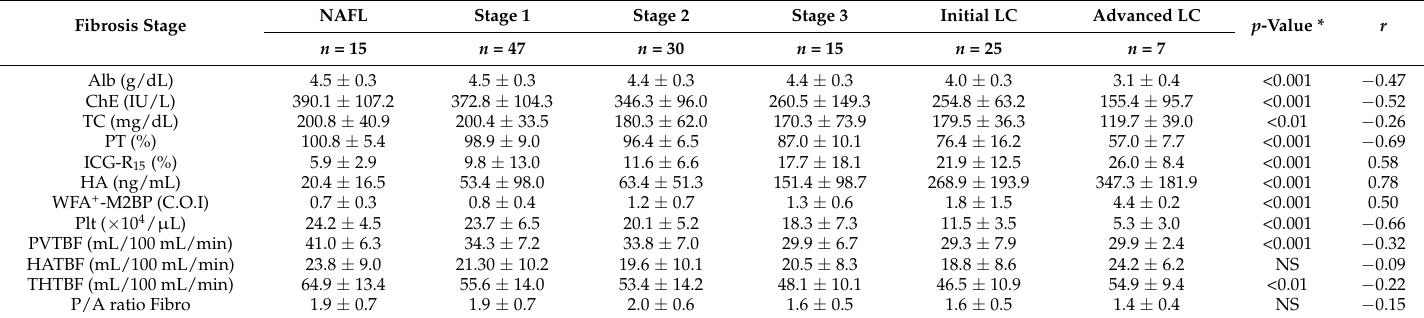
Table 3. Liver function and hepatic tissue blood flow in each fibrosis stage in NAFLD.